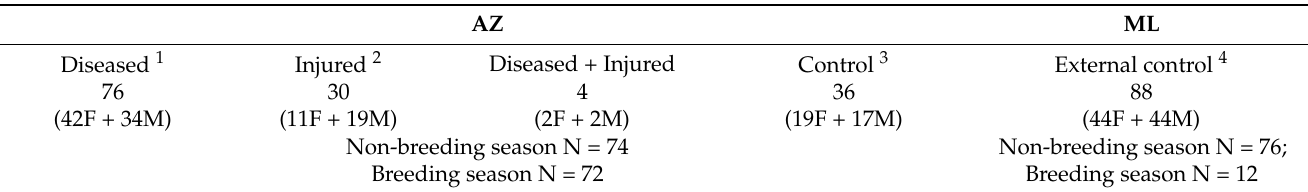
Table 1. Koalas used for the study: 146 from the Australia Zoo Wildlife Hospital (code: AZ) and 88 from a study conducted by Endeavour Veterinary Ecology at The Mill (code: